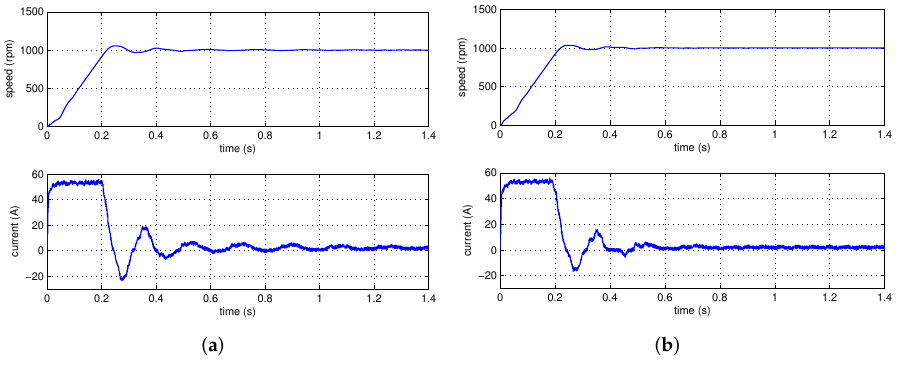
Figure 7. Step response comparisons. ( a ) IOPD-ESO. ( b ) FOPD-ESO. Table 3. Step response performances of IOPD-ESO and FOPD-ESO.